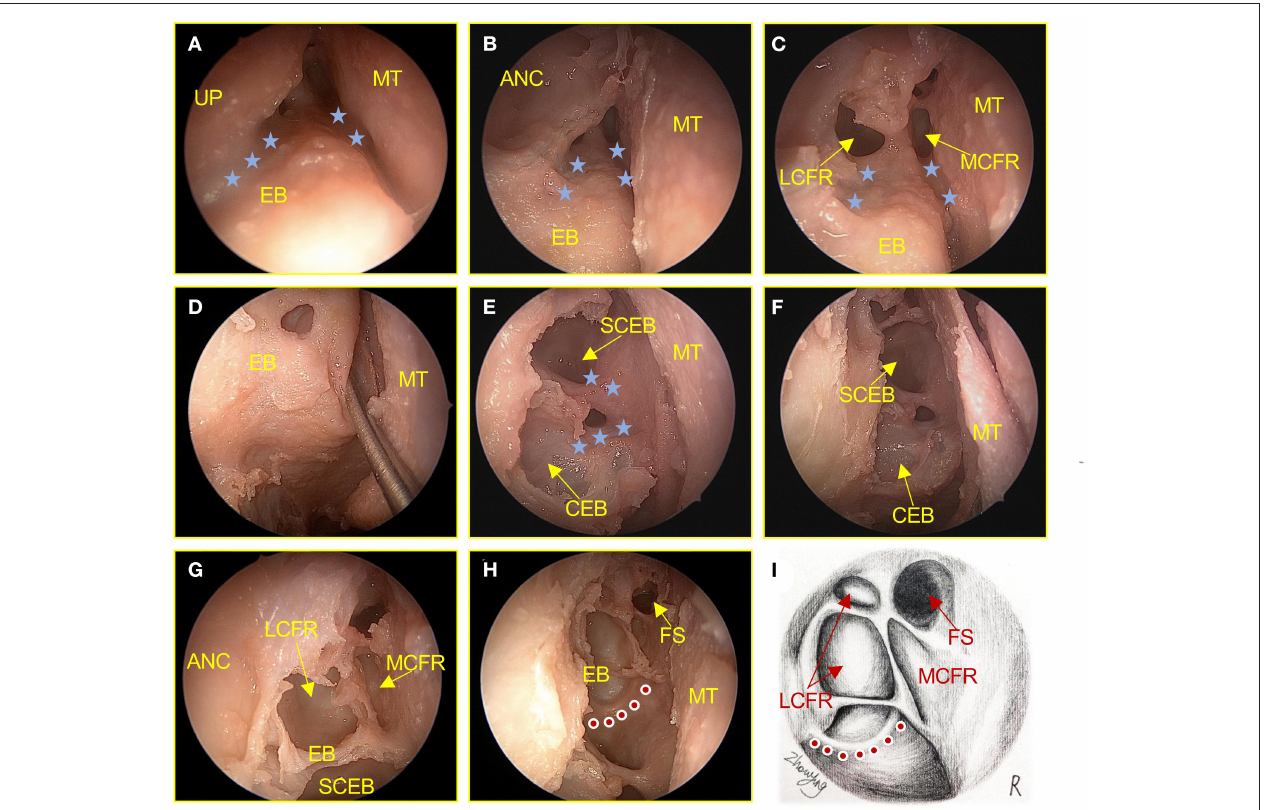
FIGURE 1 | Surgical procedures of the anterior ethmoid sinus in an adult cadaver head (right). (A) The UP, MT, and EB of the frontal recess were examined with the aid of a 70 ◦ endoscope. The blue star shows the natural drainage pathway of the frontal recess. (B) The ANC was examined with the aid of a 70 ◦ endoscope. (C) The front-end bone plate was resected to expose the cells draining into the LCFR, and MCFR was examined with the aid of a 70 ◦ endoscope. (D) Drainage pathway for ethmoid bulla. (E) The front-end bone plate was resected to expose the cells of the ethmoid bulla. (F–H) Remove all bone plates to the terminal attachment to completely expose the anterior ethmoid sinus cells. The red dot shows the anterior sieve artery. (I) Hand-drawn anatomical drawings show the anterior ethmoid sinus cells were completely exposed. UP, uncinate process; MT, middle turbinate; EB, ethmoid bulla; ANC, agger nasi cells; LCFR, lateral cells of the frontal recess; MCFR, medial cells of the frontal recess; CEB, cells of the ethmoid bulla; SCEB, supra bulla cells of the ethmoid bulla; FS, frontal